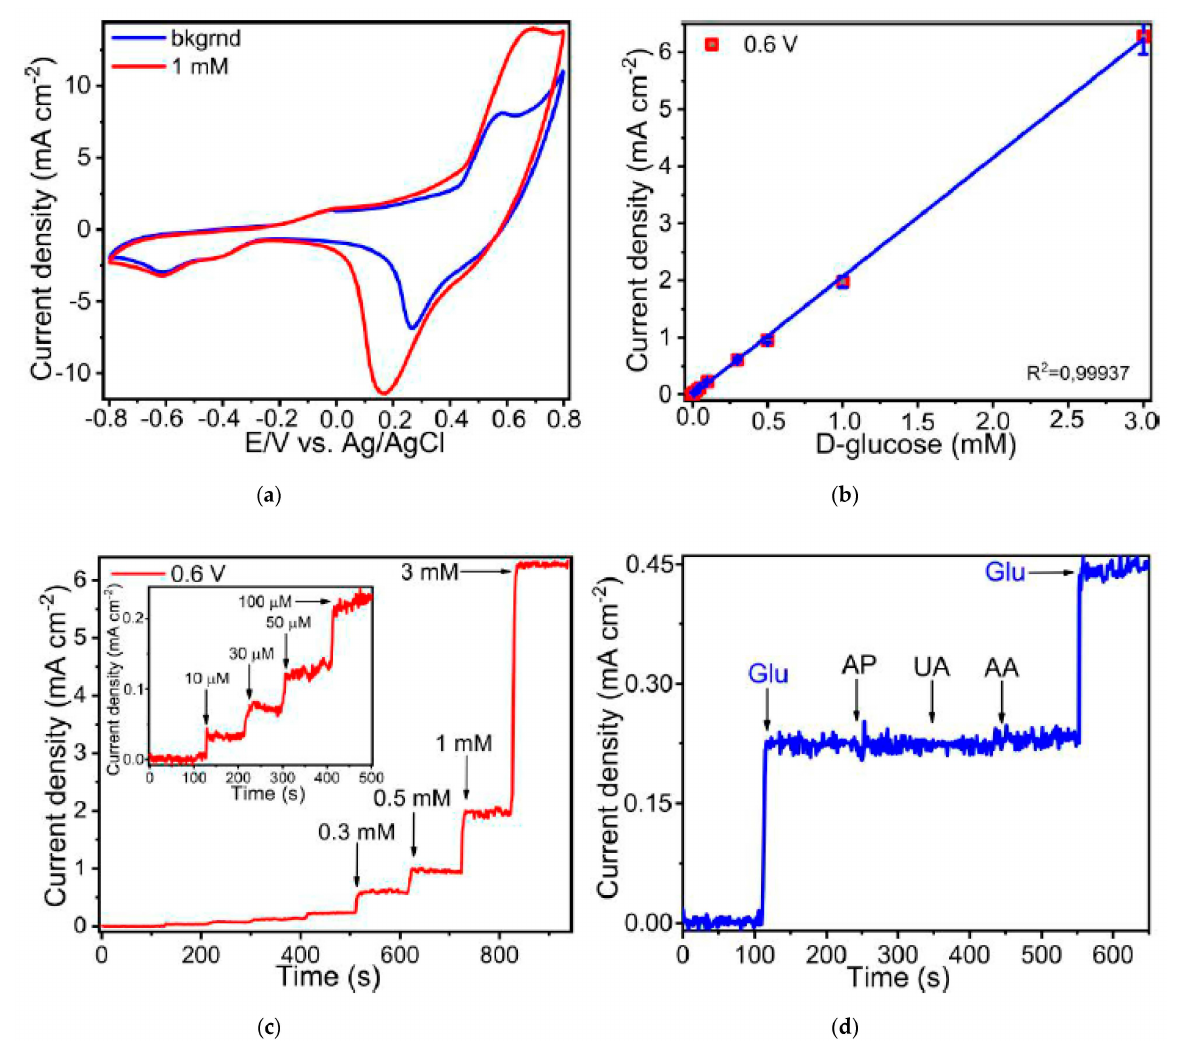
Figure 7. ( a ) Cyclic voltammograms of Ni micropatterns (electrode) measured in the solution of 0.1 M NaOH with addition of 1 mM D-glucose; ( b ) Amperogram of Ni electrode recorded at potential of 0.6 V in 0.1 M NaOH solution containing of D-glucose of various concentration; ( c ) Linear range of D-glucose concentrations for enzyme-less sensing using the fabricated Ni electrode; ( d ) Selectivity of Ni electrode towards 100 µ M D-glucose (Glu) detection in the presence of 20 µ M 4-acetamidophenol (AP), 20 µ M uric acid (UA) and 20 µ M ascorbic acid (AA) observed in the background solution of 0.1 M NaOH. In these experiments, we used Ni electrodes sintered on glass-ceramics. Table 3. Different electrode materials for non-enzymatic glucose sensing in comparison with those fabricated in this work. Electrode Material Limit of Detection ( µ M)